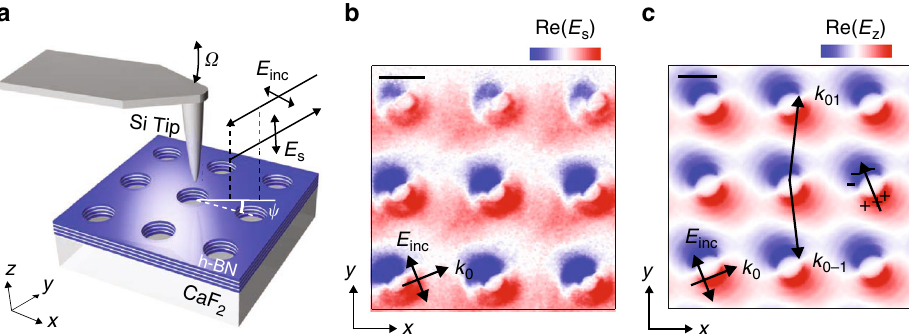
Fig. 2 Near- fi eld imaging of a Bloch mode in the h-BN polaritonic crystal. a Schematics of the experiment. b , c Experimental near- fi eld image ( b ) and simulated fi eld distribution ( c ) of the hole array with L = 900 nm at the resonant frequency 1428 cm − 1 . Black arrows indicate the direction of the electric fi eld, E k k -vectors of (0, 1) and (0, − 1) diffraction orders inc , and in-plane wave vector of the incident wave, 0 . The effective induced dipole and the constituting the Bloch mode are indicated in ( c ) by the black arrows. Scale bars in ( b , c ): 450 nm